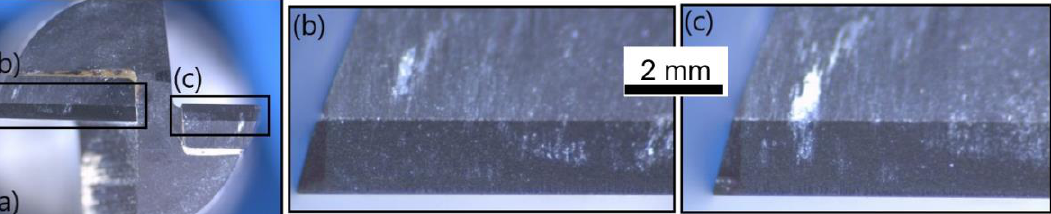
Figure 20. T3: Front view at the worn state: ( a ) global view of the end-mill, ( b ) zoom on the clearance face of the first cutting edge and ( c ) zoom on the clearance face of the second cutting edge.